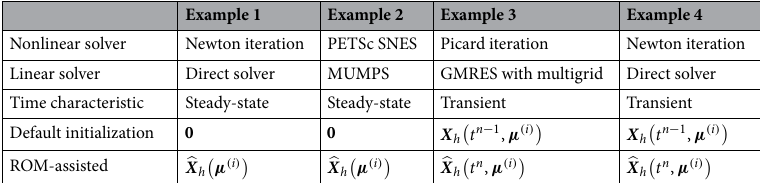
Table 2. Summary of each example’s nonlinear solver scheme and